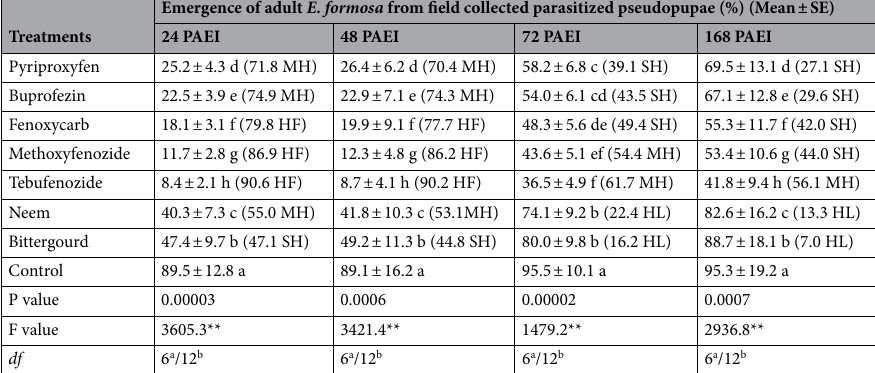
Table 3. Percent emergence and mortality of adult E. formosa when parasitized pseudopupae were exposed to different insecticides at different post-application exposure intervals on field cultivated Bt cotton. Means with the same lowercase letters are not significantly different at α = 0.05 (Tukey’s test). Values in parenthesis indicate the corrected percent mortality of E. formosa inside the parasitized whitefly pseudopupae over control at different PAEI. HL, SH, MH and HF abbreviations inside the parenthesis indicate Harmless/Class-I, Slightly- harmful/Class-II, Moderately-harmful/Class-III and Harmful/Class-IV insecticides, respectively. df Degree of freedom. P, F and Df values = the respective times listed above. a Degree of freedom of treatment. b Error degree of freedom. **Highly significant at probability level of 5%.